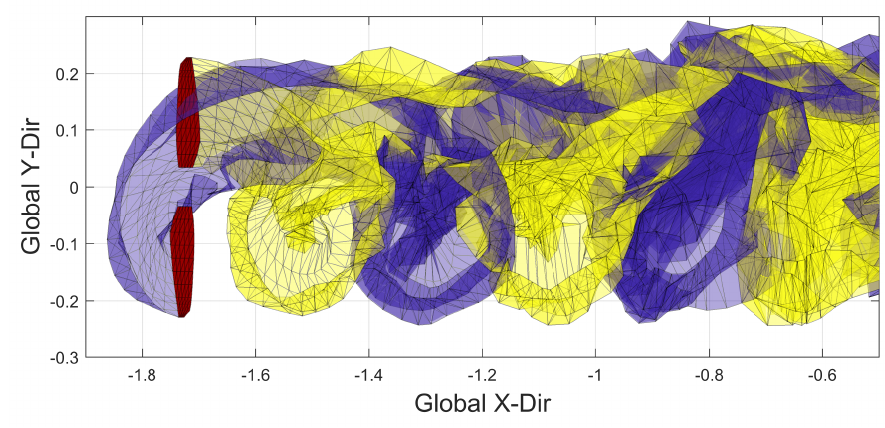
Figure 8. Top-down view of a rotor in fully-edgewise flow using a relaxed-wake